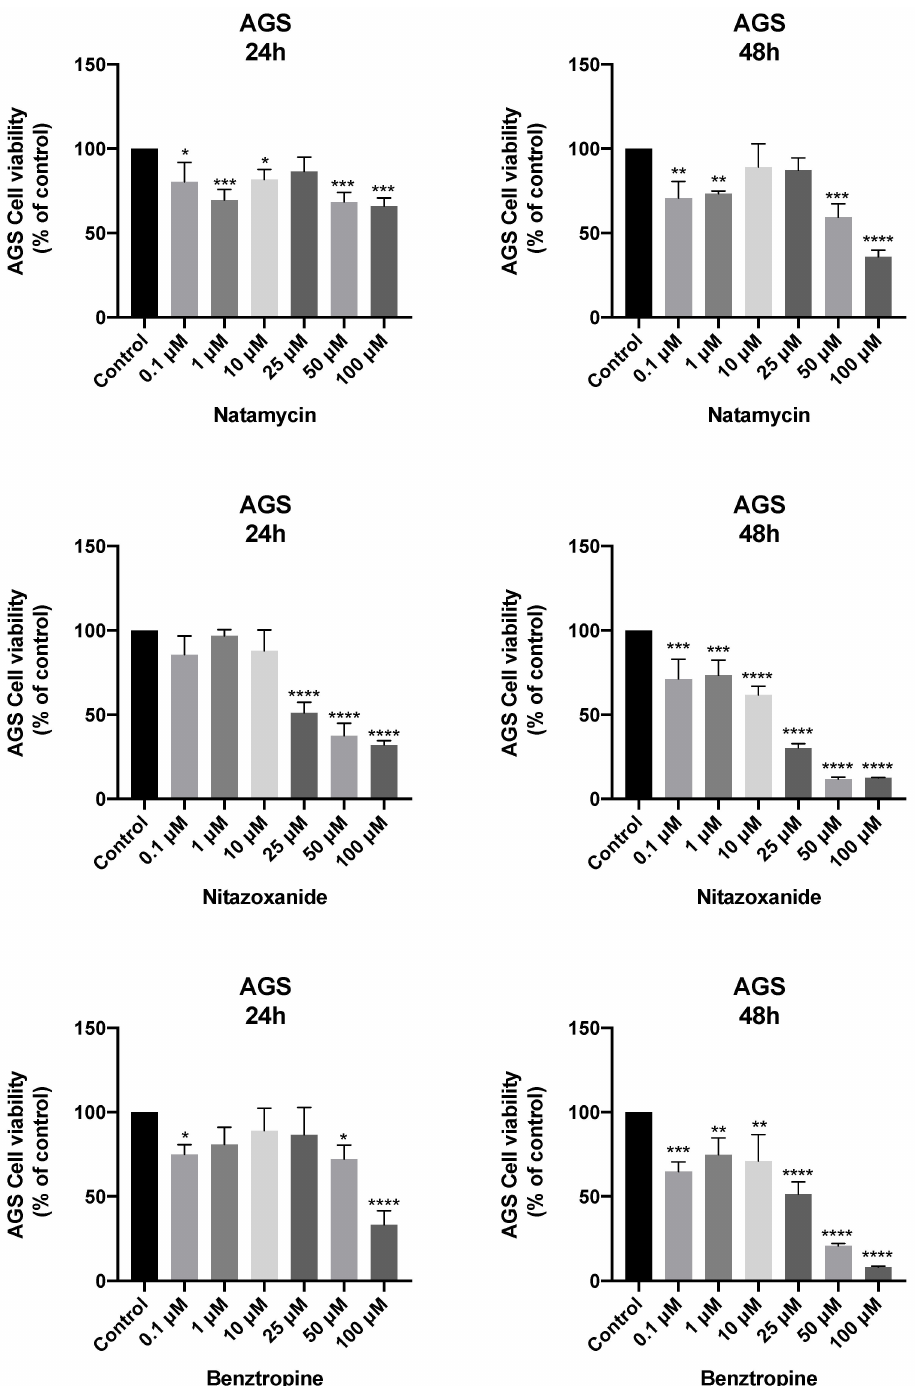
Figure 9. Viability of AGS GC cells incubated with different repurposed drugs alone. Cultured cells were seeded in 96-well plates and treated with each drug alone (0.1–100 µ M) for 24 and 48 h. Values are expressed as percentages of control and represent means ± SEM. Each experiment was conducted three times independently ( n = 3); * statistically significant vs. control at p < 0.05; ** statistically significant vs. control at p < 0.01; *** statistically significant vs. control at p < 0.001; **** statistically significant vs. control at p <